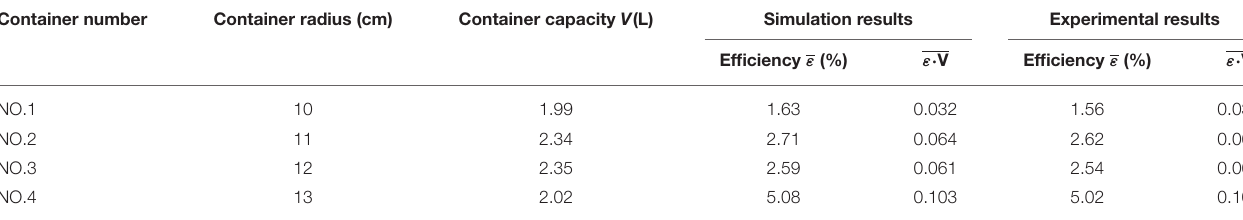
TABLE 4 | Comparison of the simulated and measured